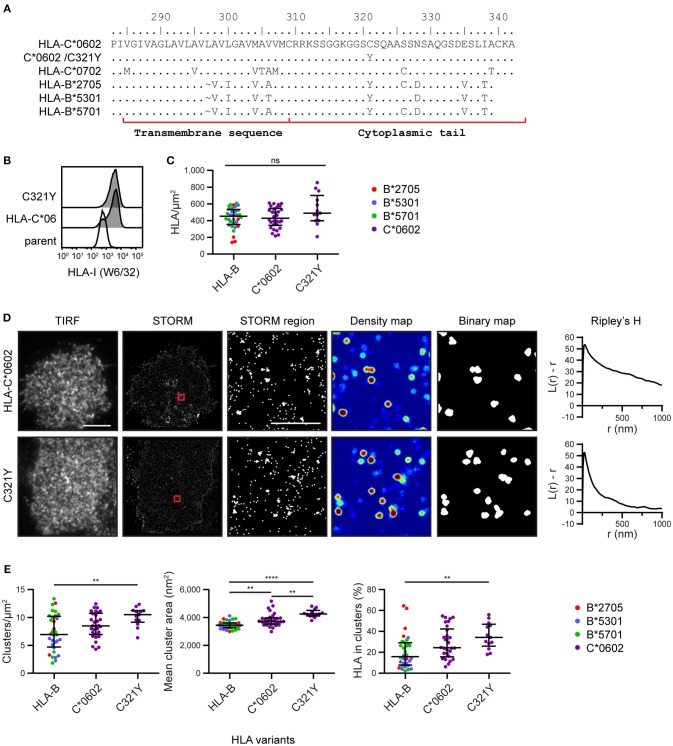
Nanoscale clustering of HLA-C is not determined by cysteine 321. (A) An alignment of amino acids in the C-terminus of HLA-I allotypes. The HLA-C allotypes examined here have a cysteine at position 321, while HLA-B allotypes have tyrosine. A point mutation was introduced to create HLA-C*0602/C321Y. (B) Representative flow cytometry plots of 721.221 cells untransfected (“parent”; white histogram) or transfected to express HLA-C*0602 or HLA-C*0602/C321Y (gray histograms) stained for folded HLA-I. (C) The density of HLA-I is plotted for HLA-C*0602/C321Y. The low expressing HLA-B allotypes and HLA-C*0602 (as shown in Figure 2) are plotted for comparison. (D) Representative TIRF microscopy and STORM images are shown for HLA-C*0602 and HLA-C*0602/C321Y (scale bar: 5 μm). STORM panels show the Gaussian-rendered image of co-ordinate data. The 1 × 1 μm regions (red boxes in STORM images) are enlarged and the corresponding scatter plots, density maps (G&F analysis) and binary maps are shown (scale bar: 500 nm). The Ripley's H function is plotted for that cell. (E) Quantitative analysis of nanoclusters. Each dot represents the mean value for a cell and colors represent different allotypes. Black bars show median and interquartile range. HLA-C*0602/C321Y (13 cells; 3 experiments); HLA-B (32 cells) and HLA-C (30 cells) as shown in Figure 2 low expressing group. Kruskal-Wallis test with Dunn's multiple comparisons (Graphpad Prism version7); **p < 0.01, ****p < 0.0001.